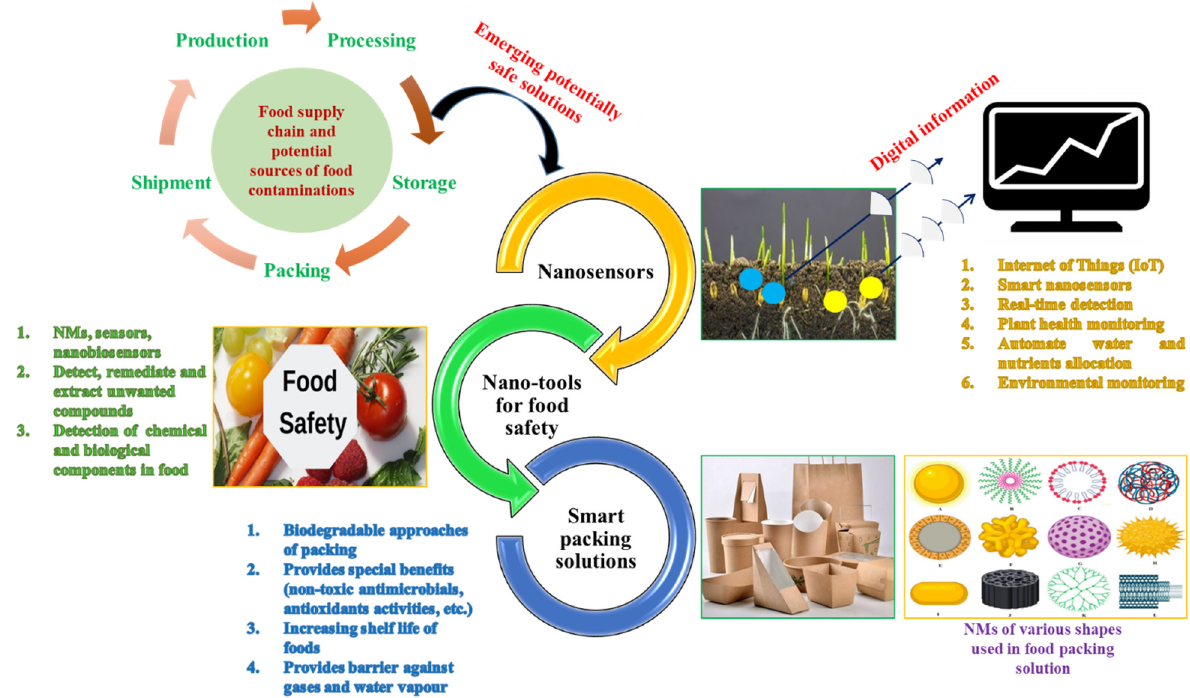
Figure 4. Graphical representation of nanosensors application in agriculture and ENMs in food safety and smart packing. The application of nanosensors, ENMs, and other novel nanotools along with computed-based control systems greatly comes up with more resilient and sustainable food production, processing storage, packing, and transportation systems.